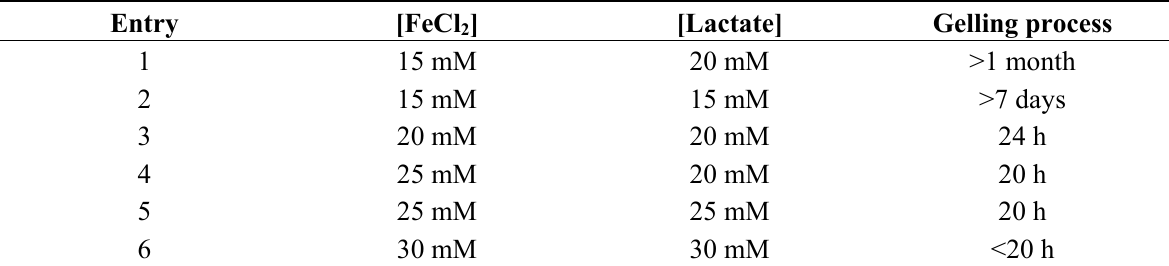
Table 1. Minimal time required for production of hydrogel in solution